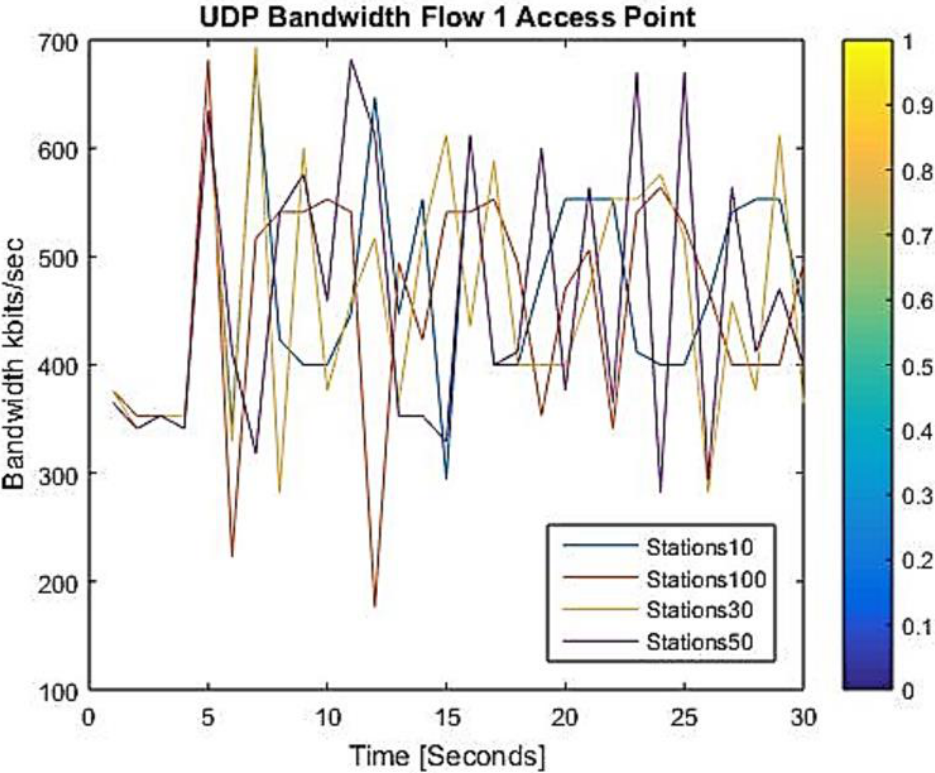
Figure 10. UDP bandwidth for 1 access point.